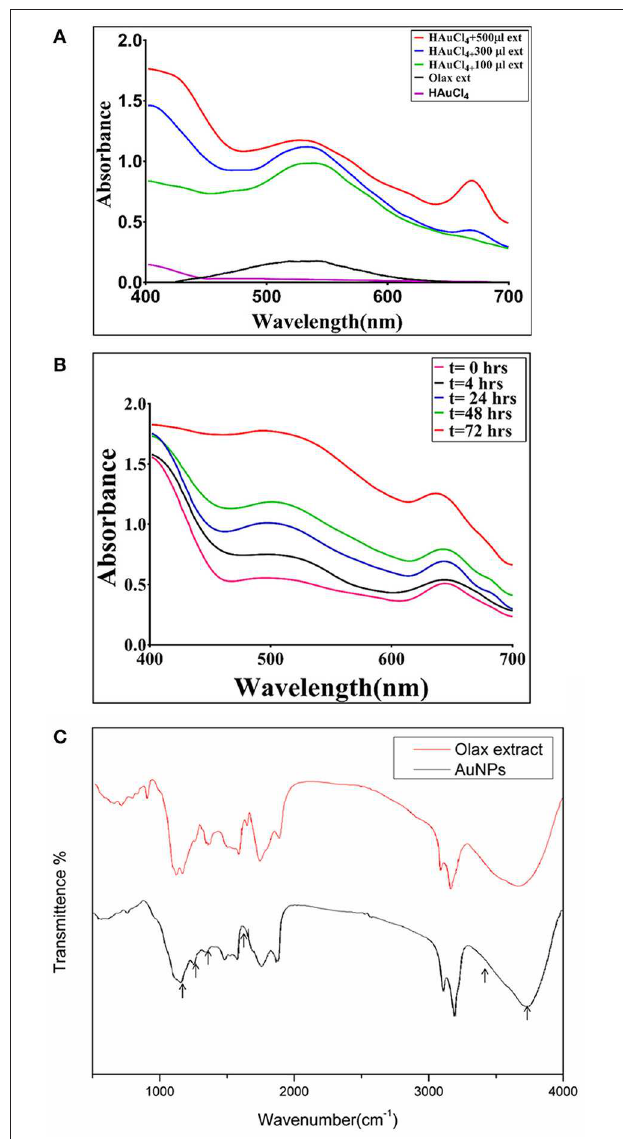
FIGURE 1 | (A) UV–visible absorption spectrum of as-synthesized B-AuNPs fabricated with the help of Olax scandens leaf extract: UV-Visible spectra of gold nanoparticles formed upon incubation of HAuCl 4 (10 − 3 M) with increasing concentrations of Olax scandens leaf extract. The characteristic surface plasmon resonance (SPR) bands corresponding to gold nanoparticles progressively shifts toward higher wavelength with accompanying amplification in band intensity as a function of increasing amounts of O lax scandens leaf extract added to the incubation mixture. (B) Time dependent kinetics of the B-AuNPs synthesis in the presence of Olax scandens extract: The time dependent kinetics of gold nano-particle synthesis, as elucidated by UV scanning of the incubation mixture at various time point. The characteristic surface plasmon resonance (SPR) band of gold nanoparticles progressively increases with time, signifying the formation of gold NPs. (C) Representative FTIR spectrum of as-synthesized B-AuNPs: FTIR spectra of as-synthesized gold nanoparticles generated upon incubation of Olax scandens leaf extract with aqueous solution of HAuCl 4 . Red Curve, represenative of pure Olax scandens leaf extract, black curve corrresponds to as-synthesized gold nanoparticles produced upon reduction of chloroauric acid by leaf extract